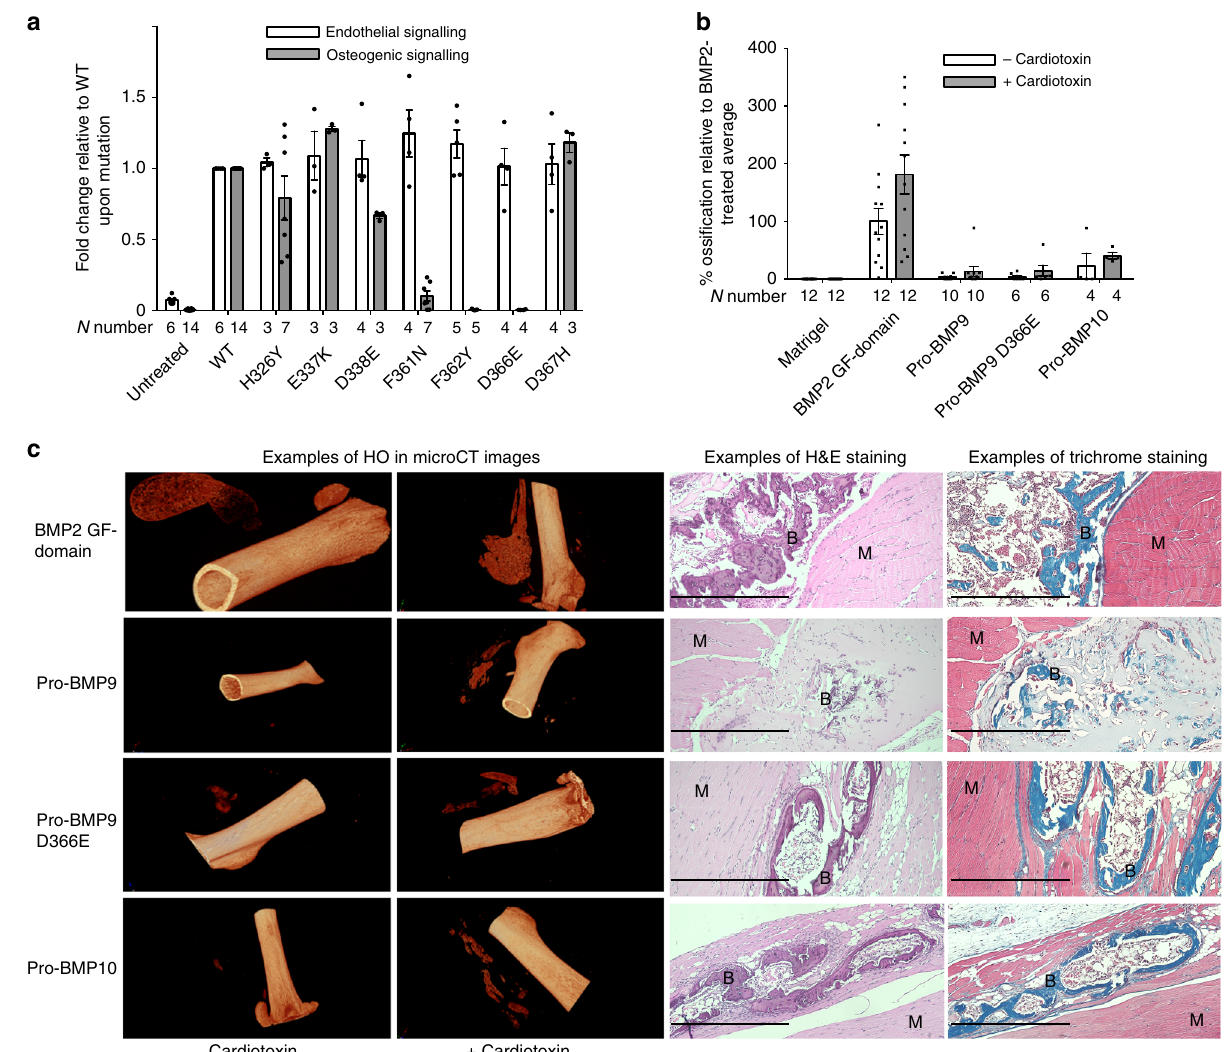
Fig. 8 Modifying BMP9 signalling speci fi city by mutagenesis. A panel of BMP9 mutants were generated, and tested in vitro and in vivo as described in the Methods. a Mutant proteins were subject to endothelial cell signalling assays (at 0.3 ng ml − 1 GF-domain concentration) using induction of ID1 gene expression in hPAECs as a readout, and osteogenic signalling assays (at 10 ng ml − 1 GF-domain concentration) using ALP induction in C2C12 cells as a readout. Data were normalised to WT BMP9 and shown as fold change relative to WT upon mutation. Each treatment condition was repeated in 3 – 7 independent experiments alongside untreated and WT controls. The exact N number for each condition is given under the column. Means ± SEM are shown. b Recombinant WT pro-BMP9, pro-BMP9 D366E, pro-BMP10, as well as BMP2 GF-domain were subject to in vivo heterotopic bone-forming assays in the presence and absence of cardiotoxin. Each data point represents the HO result from an independent injection in one leg. N number for each treatment condition is given under each column. Data are presented as % ossi fi cation volume relative to the average of BMP2-treated controls. Means ± SEM are shown. c Representative CT images (left) and histological staining (right) of in vivo formed heterotopic bones after stimulation of indicated BMP molecules in the presence and absence of cardiotoxin. B: osteoid matrix; M: muscle cells. Scale bar = 500 µ